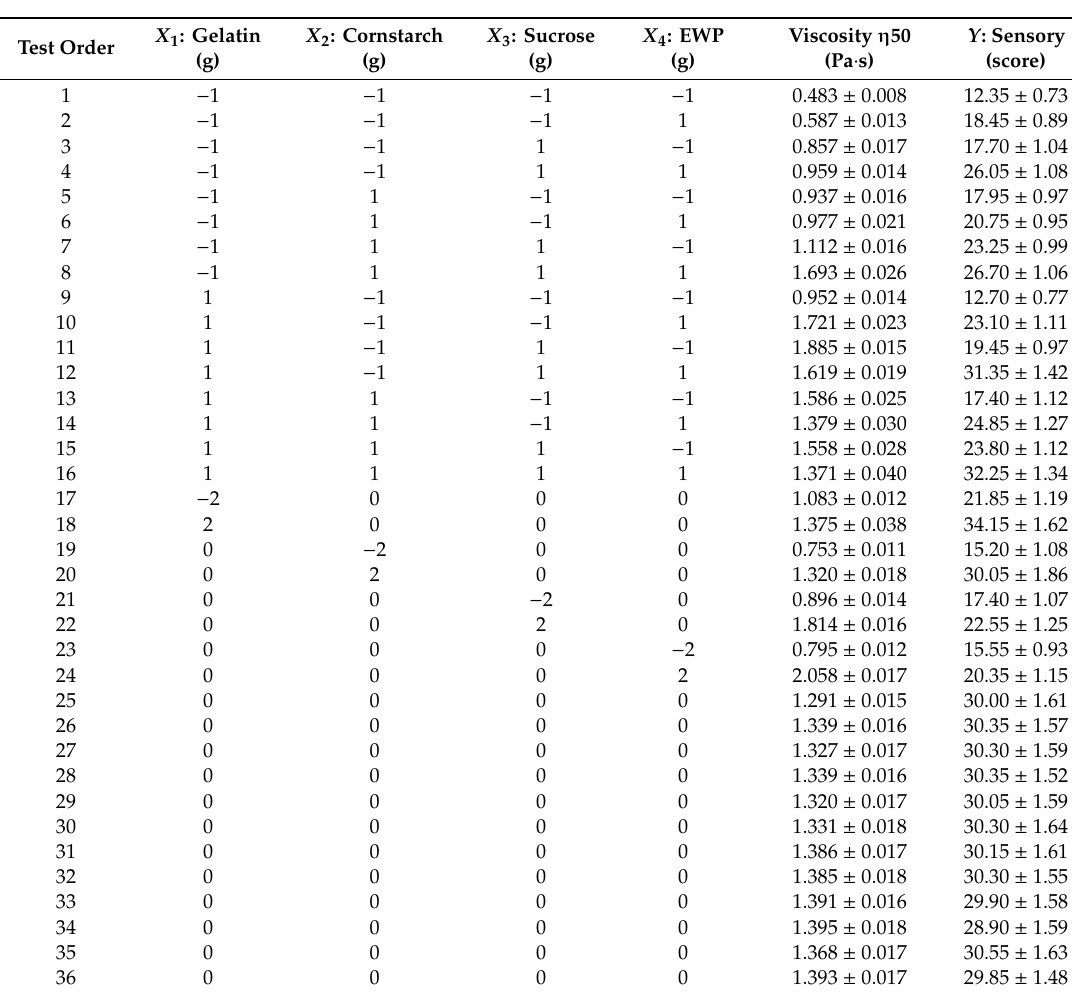
Table A2. Central composite design (CCD) matrix and experimental data for the responses. Test